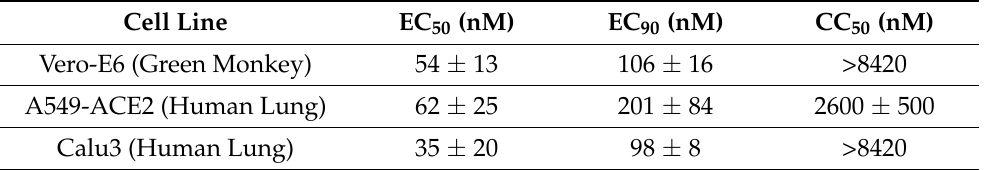
Table 1. Potency and cytotoxicity indexes of commercially available PheoA. Values are provided as mean and standard deviation of three biological replicates ( n =